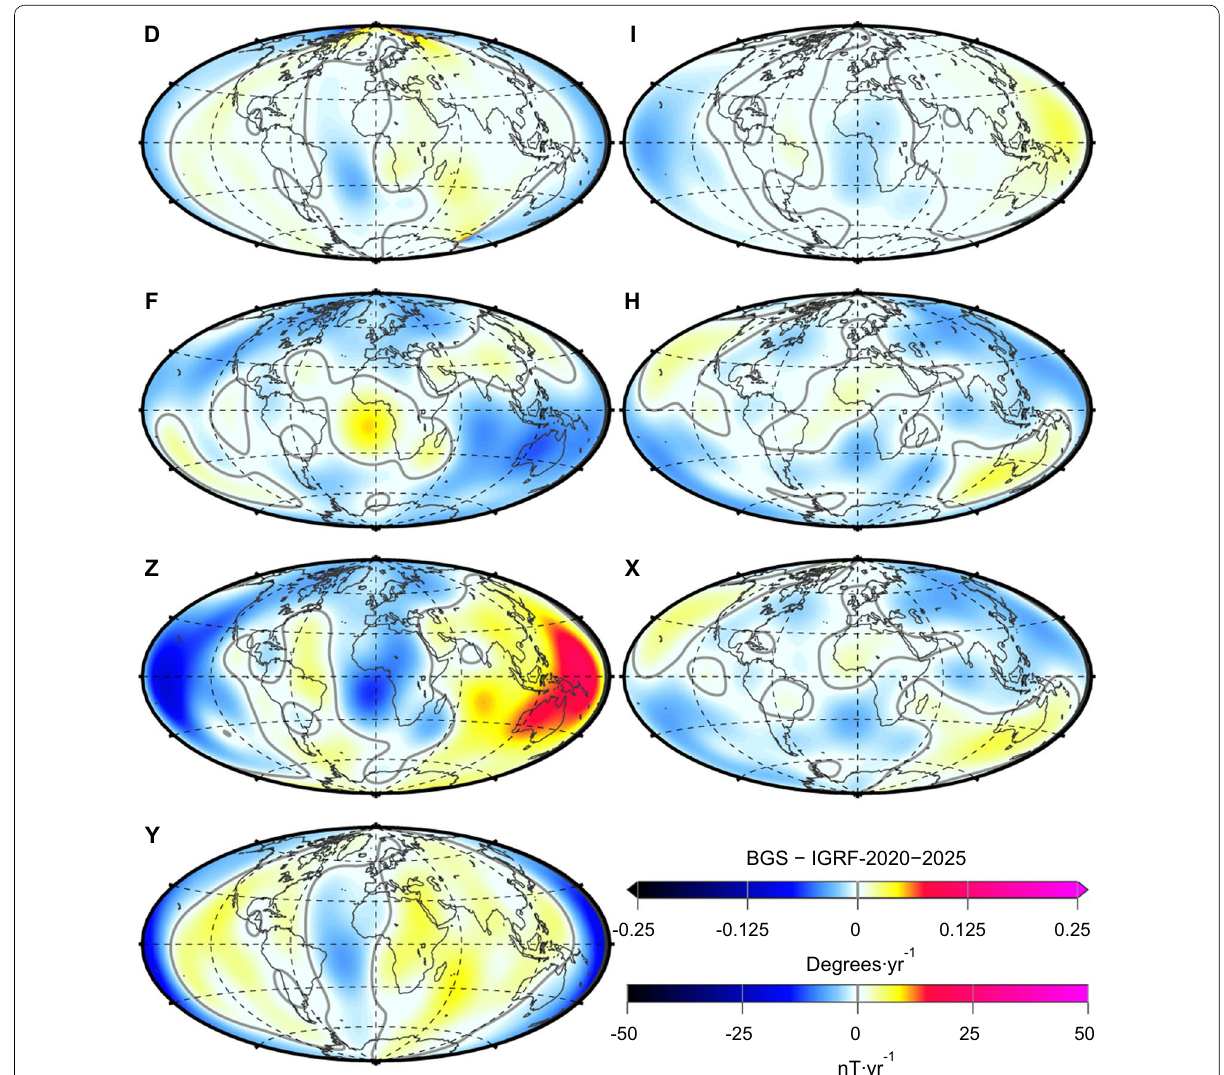
Fig. 7 Difference in each magnetic component between the BGS SV candidate model and IGRF-13 SV for 2015–2025 (spatially Huber-weighted mean of IGRF-13 candidates). Values of contours (grey lines) are marked on the colour scales, with a thicker line for the zero